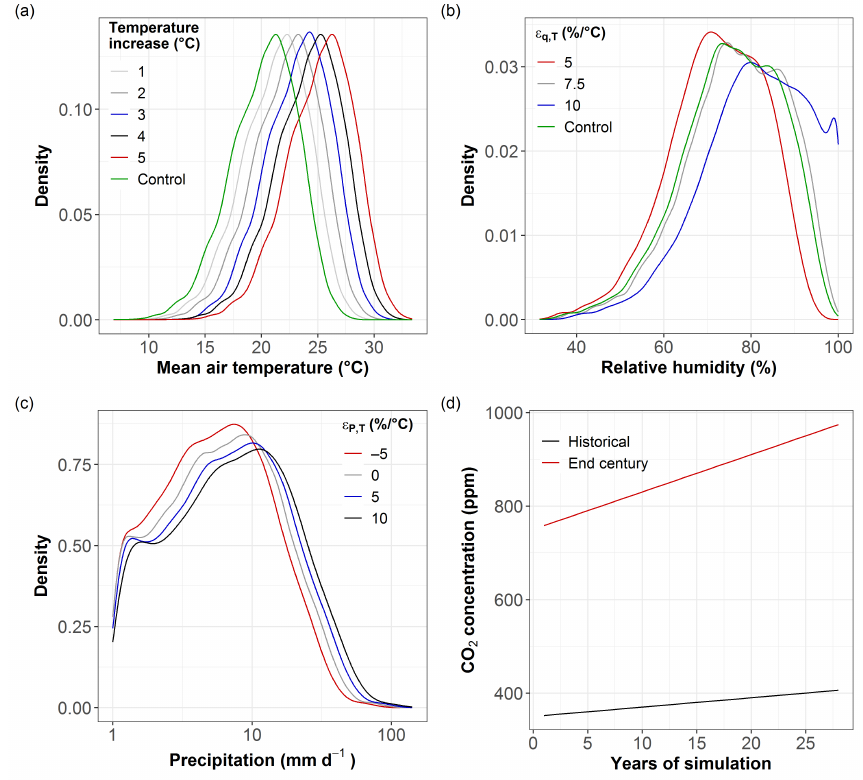
Figure 3. Density plot of ( a ) mean air temperature, in ◦ C; ( b ) relative humidity, in %; and ( c ) precipi- tation, in mm d − 1 . Colors differentiate, respectively, the increase in temperature, (cid:101) q , T and (cid:101) P , T cases. ( d ) CO 2 concentration over the years of simulation, in ppm, for historical (black line, y = 350 + 2x) and end of the century (red line, y = 750 + 8x)